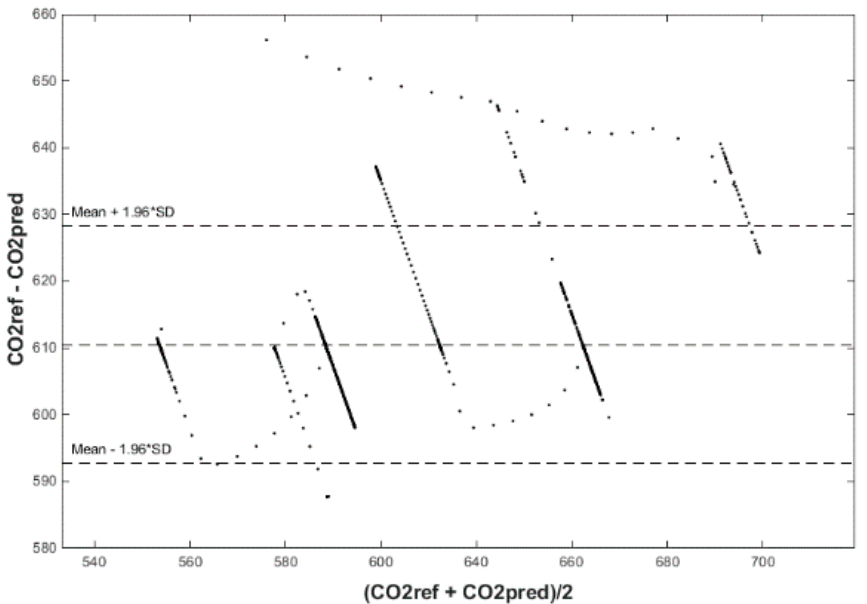
Figure 28. Comparison of the reference and predicted CO 2 waveforms (SRLMS AF) from 28 June 2018 in R204 with an ANN with 90 neurons and SCG method trained with data from 25 June 2018 in R203.